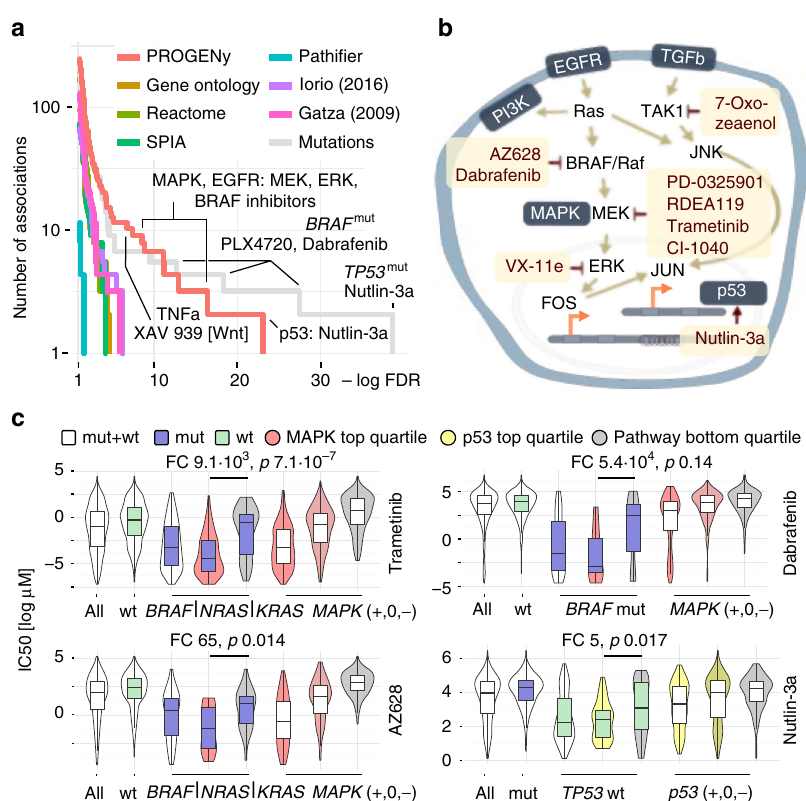
Fig. 4 MAPK and p53 scores drive drug response across all cancer types. a Comparison of the associations obtained by different pathway methods. Number of associations on the vertical and FDR on the horizontal axis. PROGENy yield more and stronger associations than all other pathway methods. Mutation associations are only stronger for TP53/Nutlin-3a and drugs that were speci fi cally designed to bind to a mutated protein. PARADIGM not shown because no associations < 10% FDR. markers (green) and greater than zero resistance markers (red). P values FDR-corrected. b Pathway context of the strongest associations (Supplementary Fig. 10) between EGFR/MAPK pathways and their inhibitors obtained by PROGENy. c Comparison of strati fi cation by mutations and pathway scores. MAPK pathway ( BRAF , NRAS , or KRAS ) mutations and Trametinib on top left panel, AZ628 bottom left, BRAF mutations and Dabrafenib top right, and p53 pathway/ TP53 mutations/Nutlin-3a bottom right. For each of the four cases, the leftmost violin plot shows the distribution of IC 50 s across all cell lines, followed by a strati fi cation in wild-type (green) and mutant cell lines (blue box). The three rightmost violin plots show strati fi cation of all the cell lines by the top, the two middle, and the bottom quartile of inferred pathway score (indicated by shade of color). The two remaining violin plots in the middle show mutated ( BRAF , KRAS , or NRAS ; blue color) or wild-type ( TP53 ; green color) cell lines strati fi ed by the top- and bottom quartiles of MAPK or p53 pathways scores (Mann – Whitney U -test statistics as